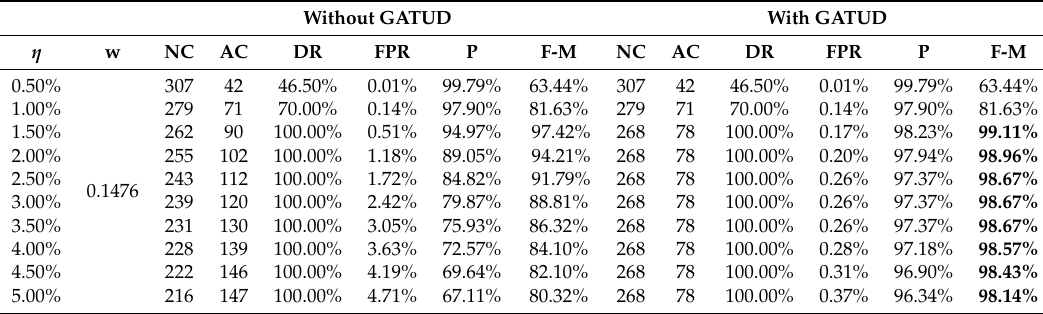
Table 11. The detection accuracy of the proximity-detection rules that have been extracted with/without the integration of GATUD in the separation process on SimData2.